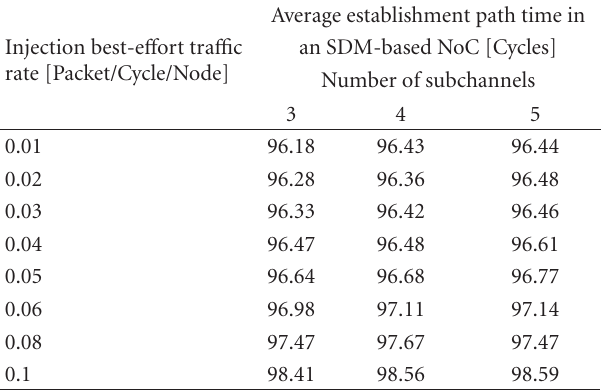
Figure 27: Average latency. Table 1: Average time to set up a path in a 7 × 7 SDM-based NoC.